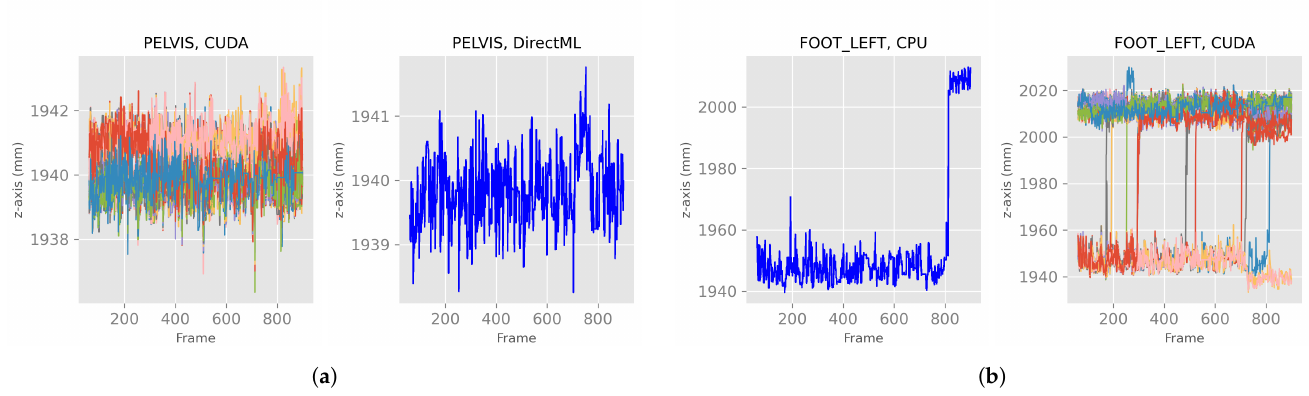
Figure 5. X -, y -, and z -axes of the joint positions of PELVIS and FOOT_LEFT for all four pro- cessing modes—extract of relevant plots (Figures for all processing modes and axis are shown in Figure A1). ( a ) Examples of a stable, steady value range. ( b ) Examples of a switch between two steady value